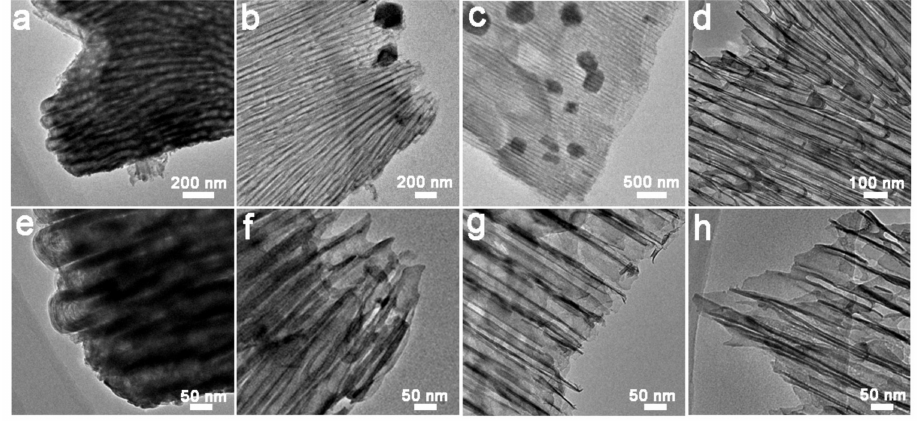
Figure 5. TEM images of TiA-450 ( a , e ), Ti10NbA-450 ( b , f ), Ti10Nb0.5FeA-450 ( c , g ) and Ti10Nb1FeA- 450 ( d , h ).